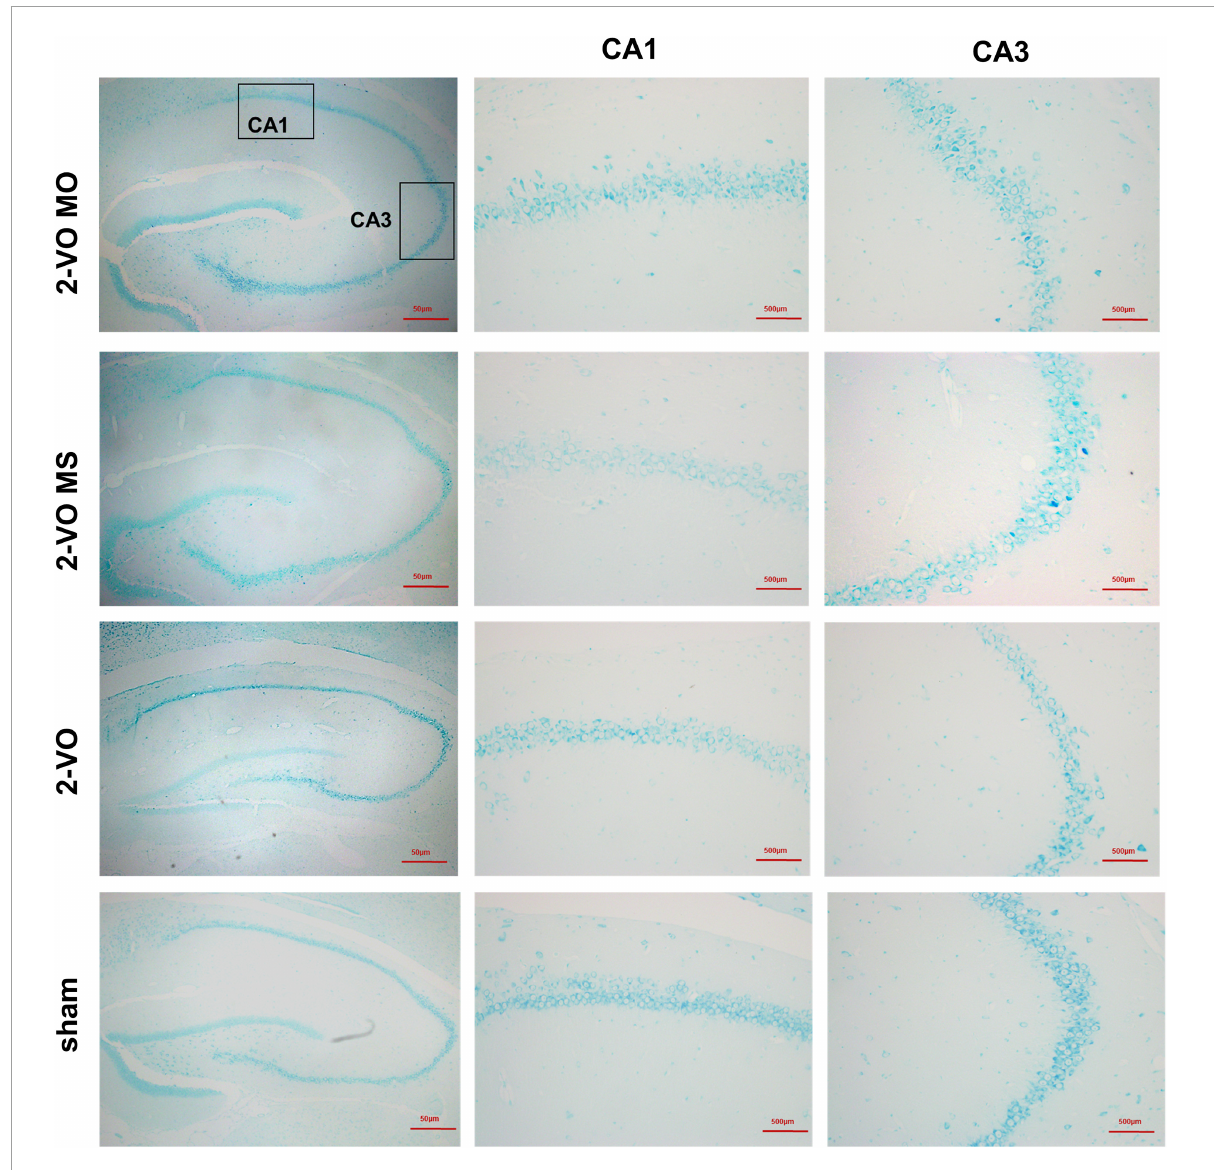
FIGURE3 Effects of molar loss on the CA1 and CA3 neurons morphology in 2-VO rats’ hippocampus (Nissl’s staining, × 200, n =